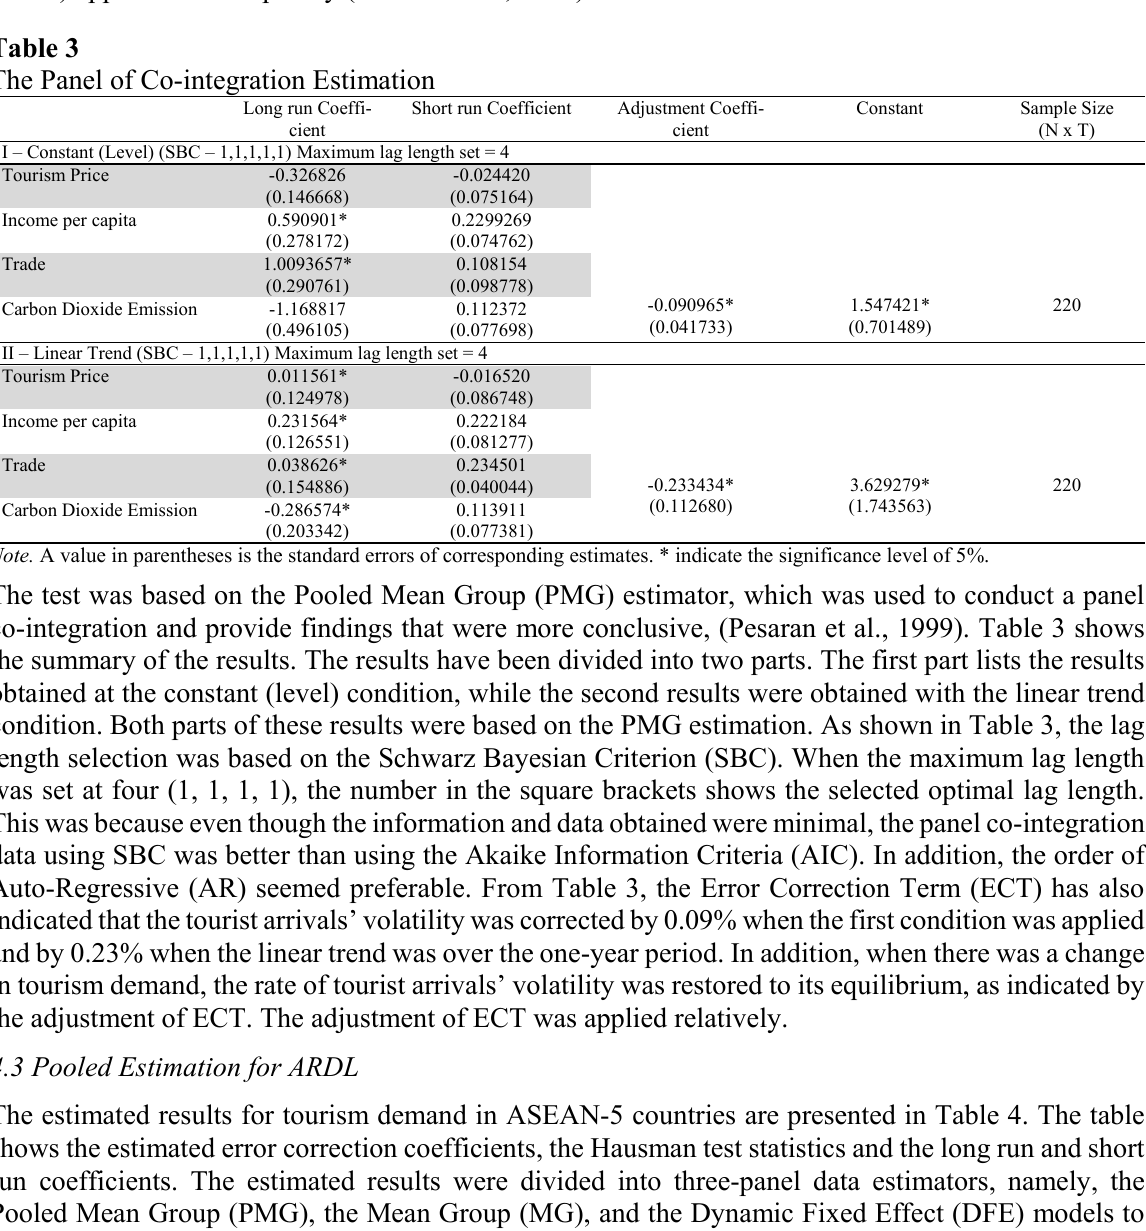
The Panel of Co-integration Estimation